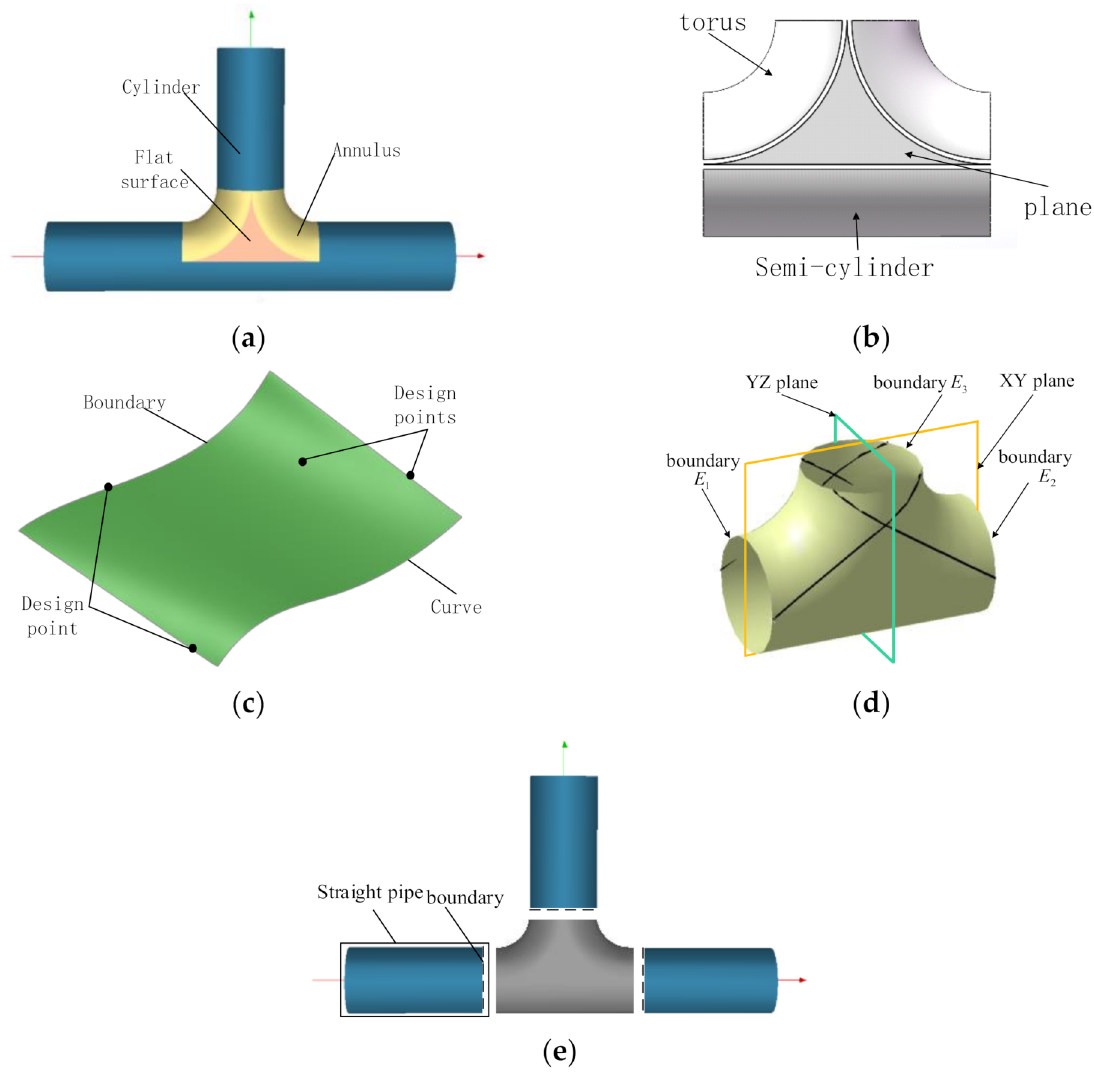
Figure 1. Schematics of the design method for illustration: ( a ) Tee pipes, ( b ) T-junction patch, ( c ) Design patches, ( d ) Symmetric trajectories, ( e ) Straight pipe